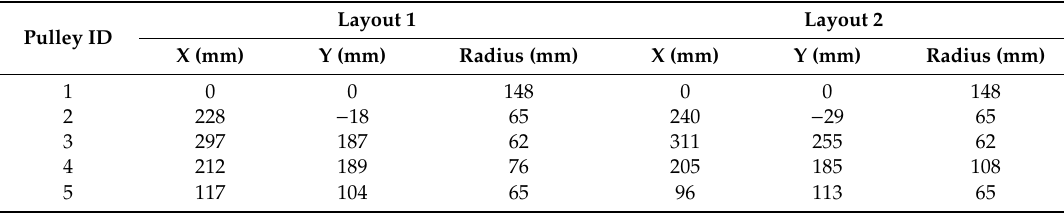
Table 2. Layouts of tested belt drive